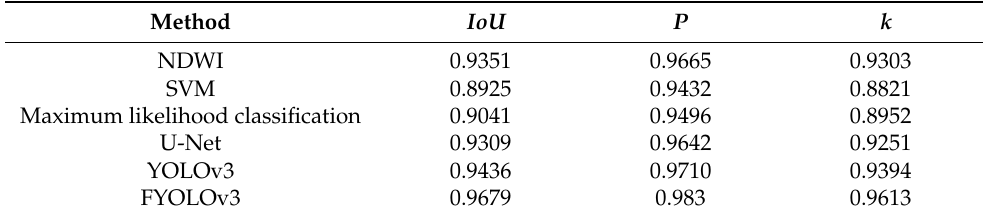
Table 4. Accuracy comparison of six methods for water extraction in tidal flat area.